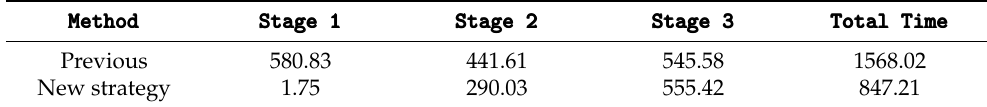
Table 6. Comparison, in hours, of both prioritization methods in each phase of the process, through a simulation of the process, taking a random sample of 100 patients (under control) waiting for care.